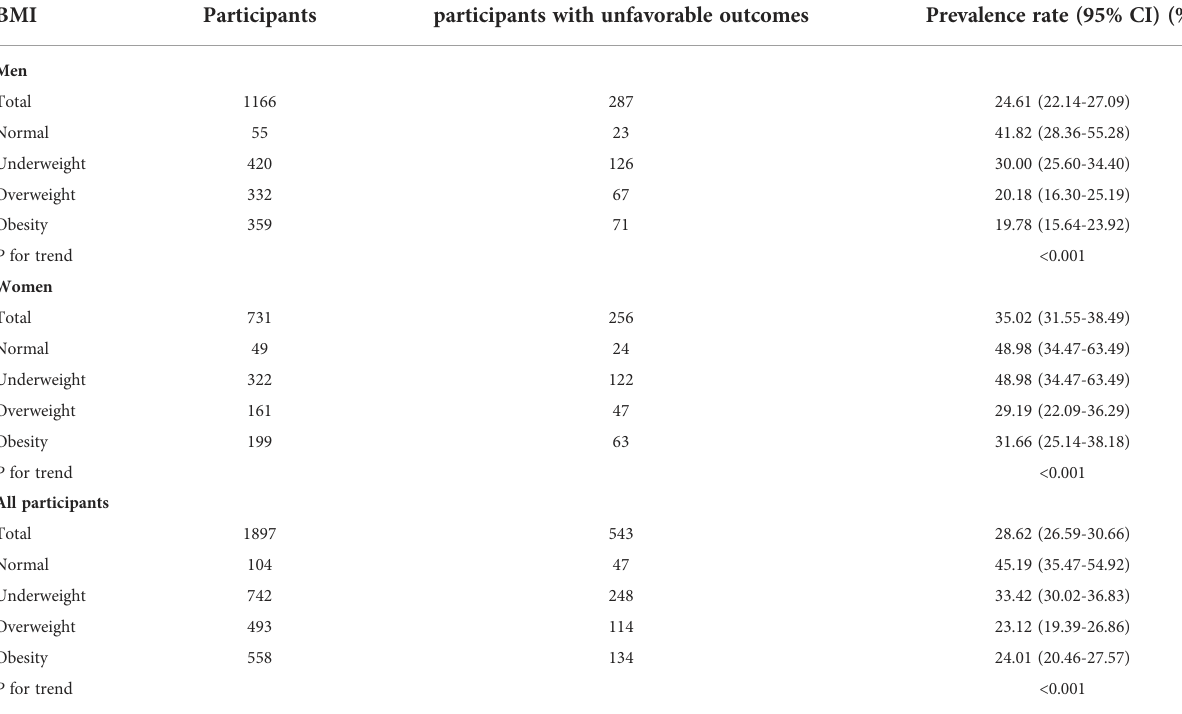
TABLE 2 Prevalence rate of unfavorable outcome (mRS score ≥ 3) 3-month after stroke in men, women and all population.